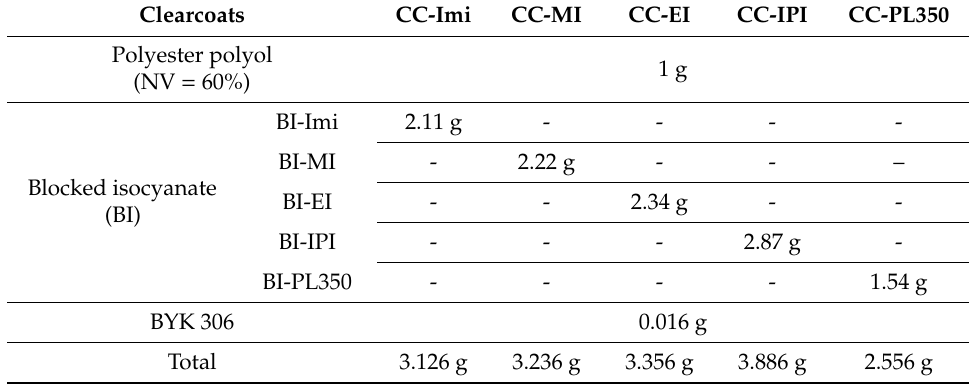
Table 1. Formulation of clearcoat samples with di ff erent imidazole-based blocked isocyanates (imidazole-Bis).